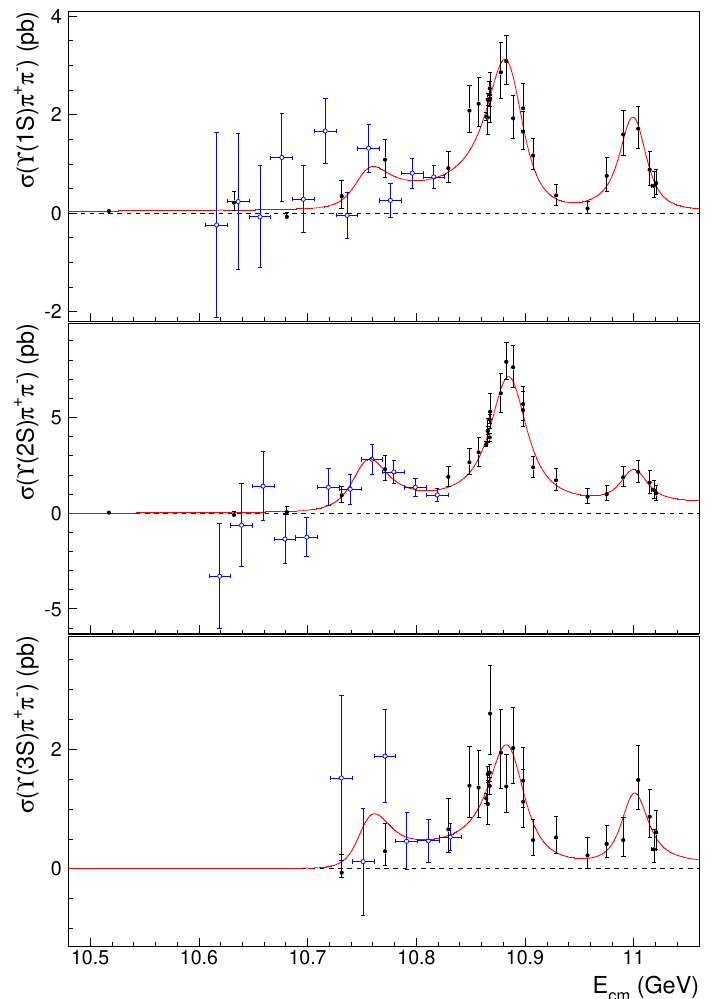
Figure 12 . Energy dependence of the e + e (cid:0) ! (cid:7)( nS ) (cid:25) + (cid:25) (cid:0) cross sections ( n = 1 ; 2 ; 3 from top to bottom). Black points with error bars and red solid histograms are the same as in (cid:12)gure 10. Blue open dots with error bars are cross sections estimated using ISR process in the (cid:7)(10860) on-resonance data. The blue dots are intended for visualisation